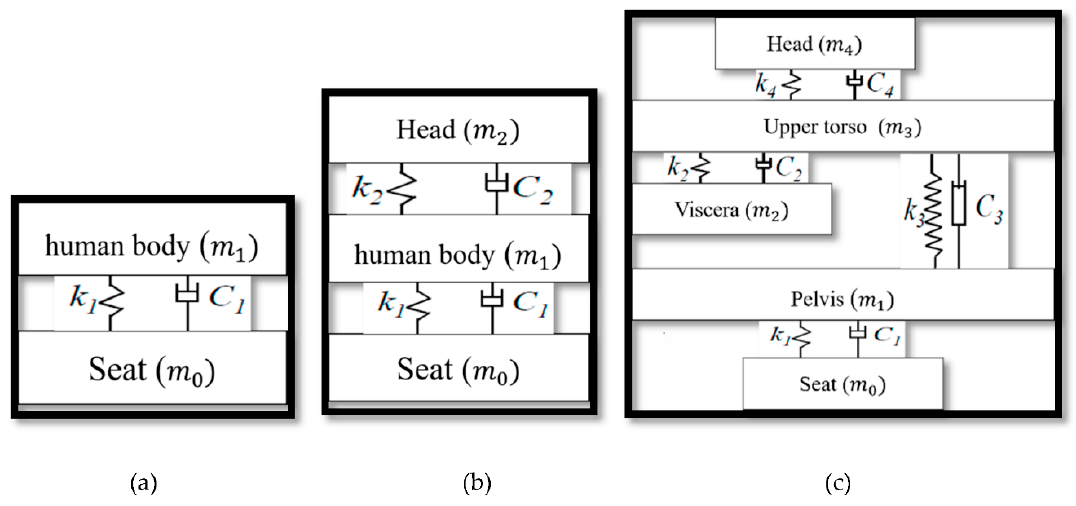
Figure 1. Biodynamic model of the seat with human body. ( a ) 1 degree of freedom (DOF) representation. ( b ) 2 DOF representation. ( c ) 4 DOF representation.